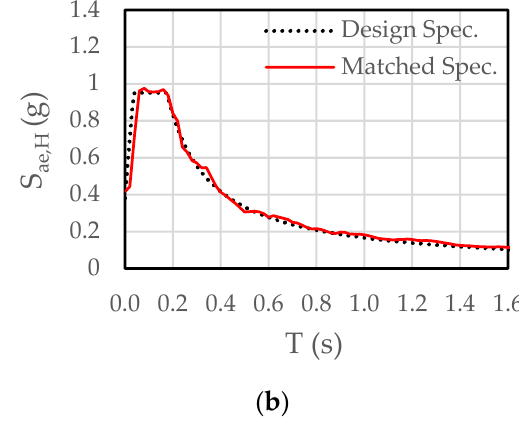
Figure 9. Site-specific design spectrums: ( a ) Horizontal; ( b ) Vertical.